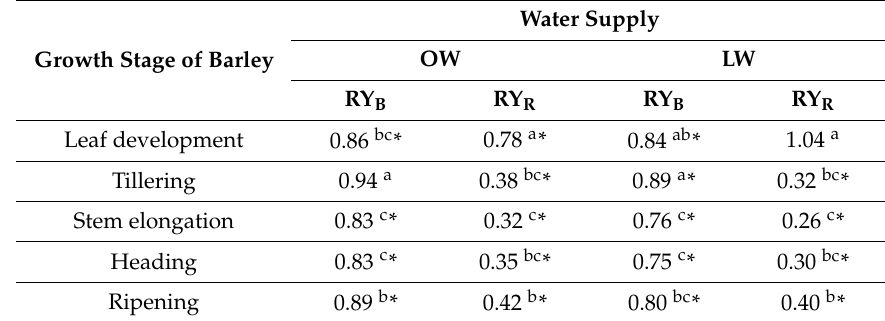
Table 4. RY values for barley and rye-grass (based on P accumulation) depending on the water supply of the plants.